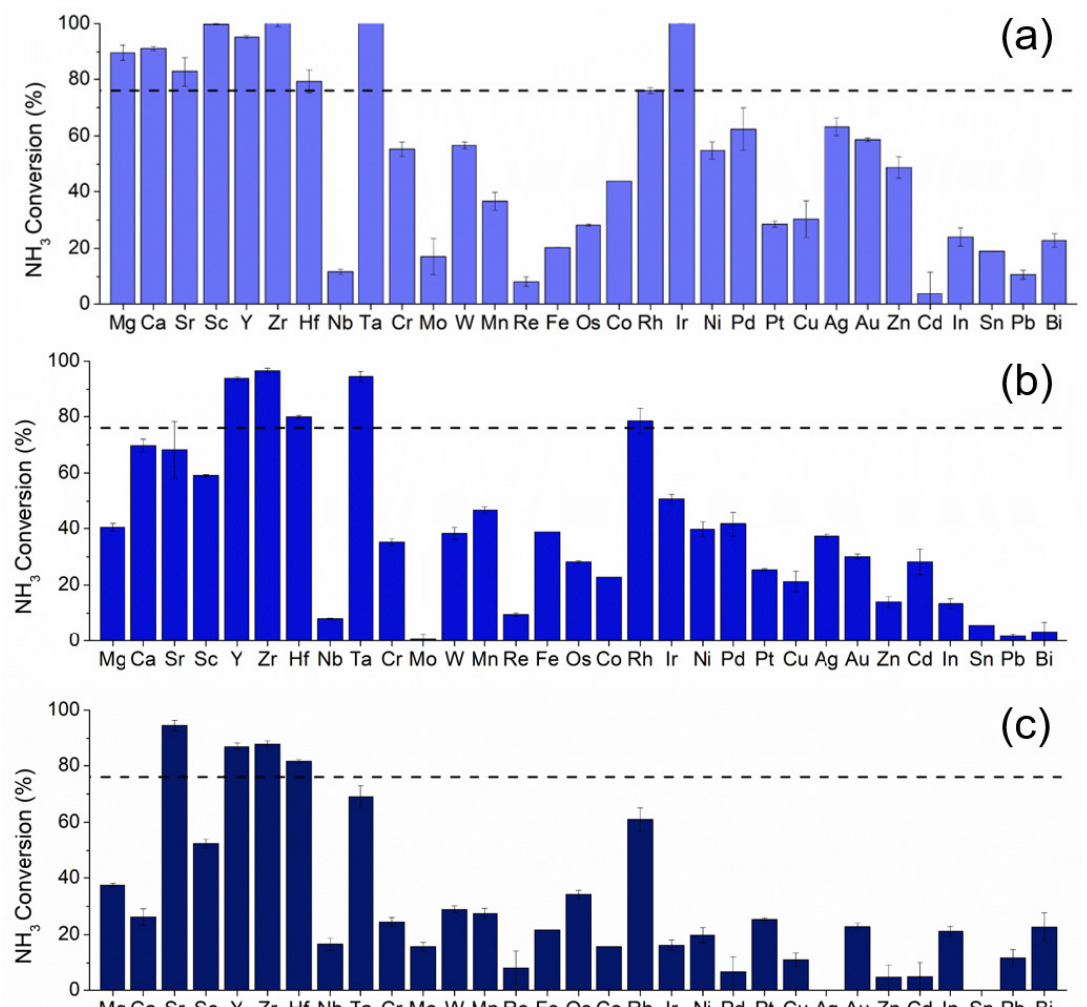
Figure 2. Catalytic activity at 300 °C of ( a ) 3,1,12 RuMK, ( b ) 2,2,12 RuMK, and ( c ) 1,3,12 RuMK, where the secondary metal M, is listed on the x ‐ axis. The black dashed line indicates the activity of the baseline 4,12 RuK catalyst at 300 °C. Reaction conditions: 1% NH 3 /Ar, 1.01 bar, 30,000 mL/hr/g cat.